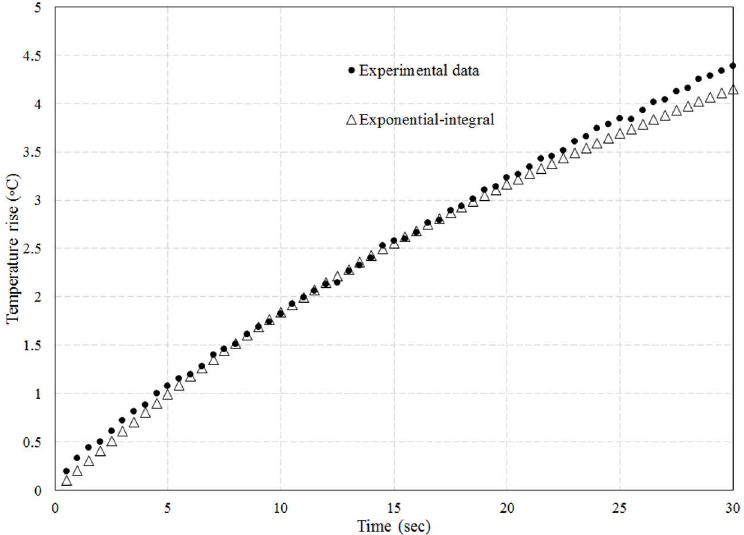
Fig 4. Experimental temperature trace at TC T1 along with fitting curve based upon exponential- integral formulation. Power = 5.2 W and mNP concentration = 0.047%.